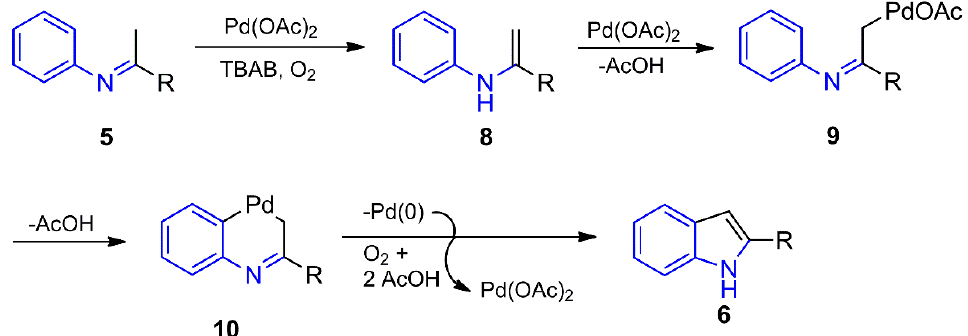
Table 3. Selection of the oxidizing agent and optimization of the reaction conditions for the one- pot conversion of 1i and 2a into indole 6h a .